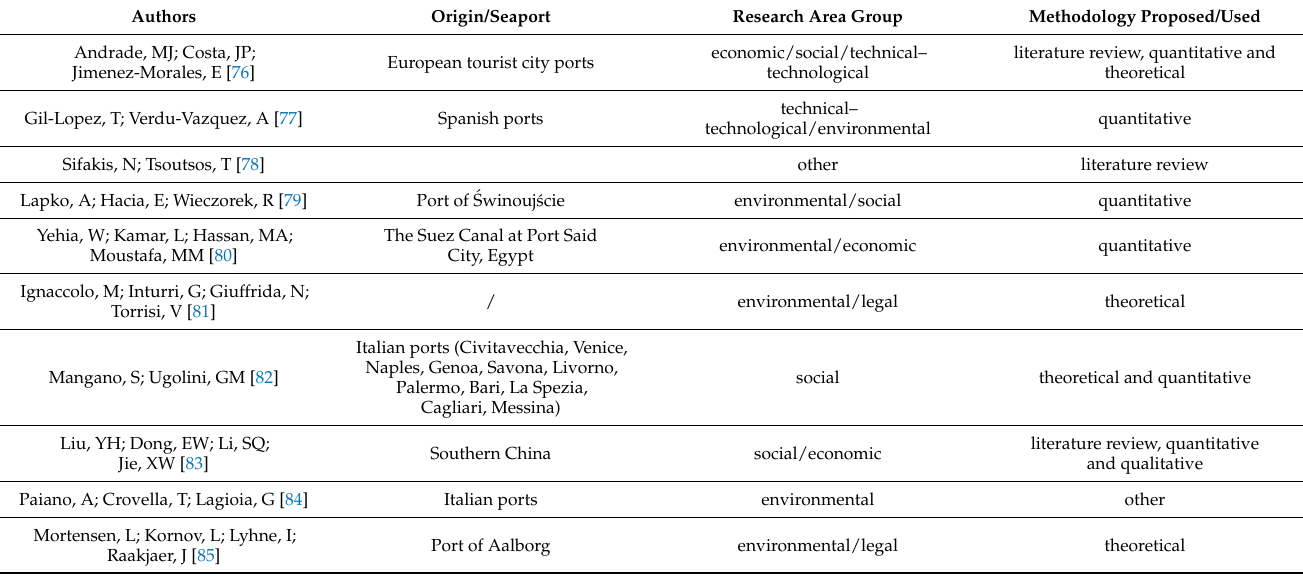
Table 2. Overview of publications that deal with sustainable passenger